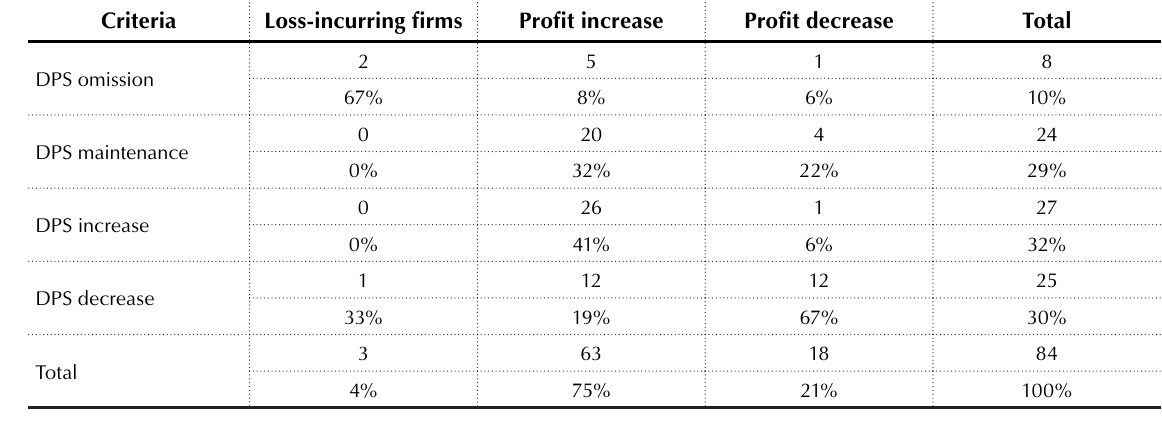
Table 9. Association between a firms’ performance and its changes in the dividend payment